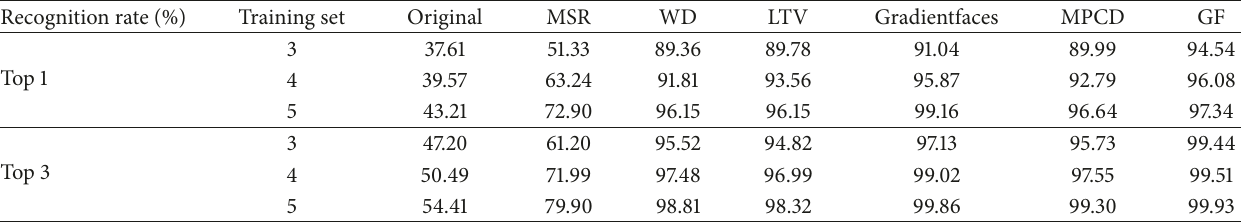
Figure 5: Comparisons on the Top 1 recognition rate (the subset 1 used as the training set). Table 1: Comparison on the recognition rate of different illumination invariants in Section 1. Recognition rate